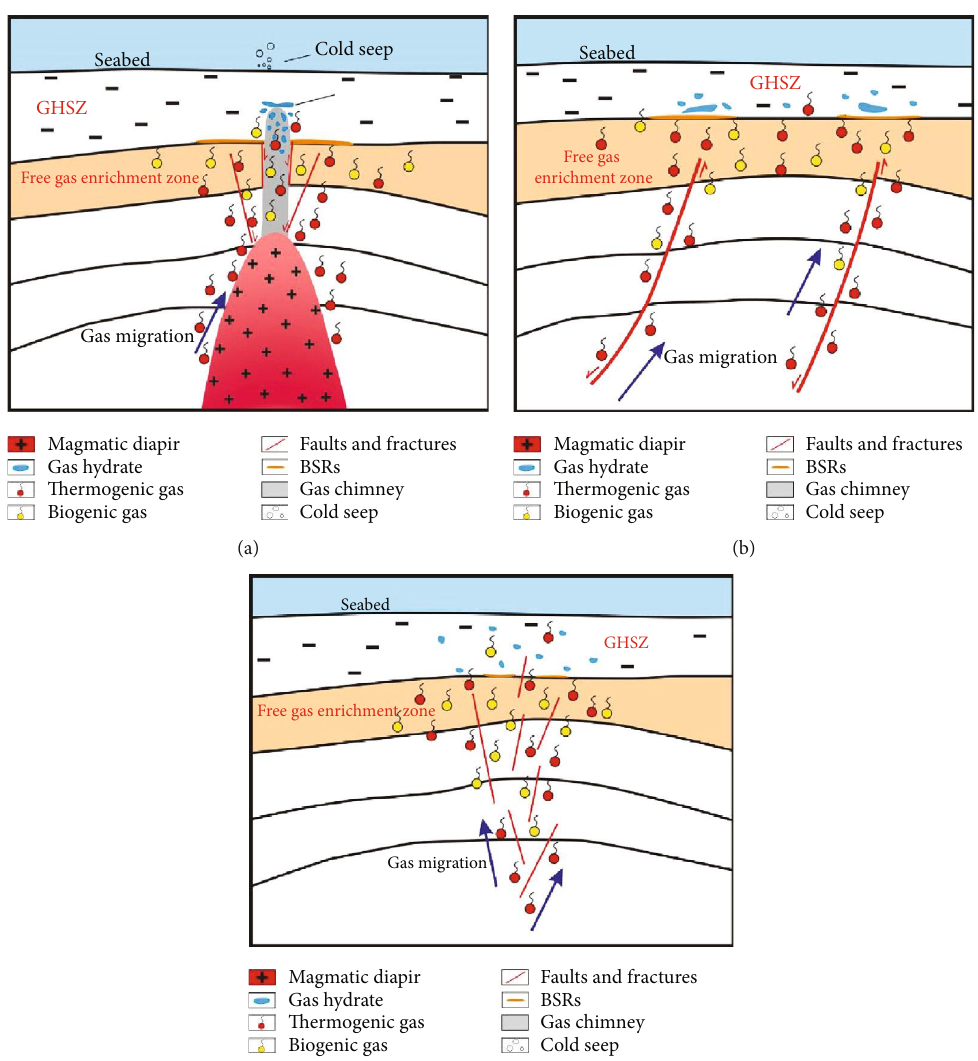
Figure 12: Hydrate enrichment models controlled by di ff erent migration pathways: (a) gas chimney; (b) fault structure; and (c) fracture